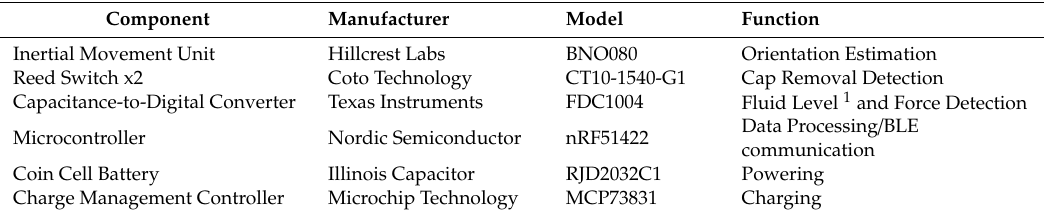
Table 1. Sensors and components embedded in the sleeve, along with the model number used in the prototype and the functionality of the